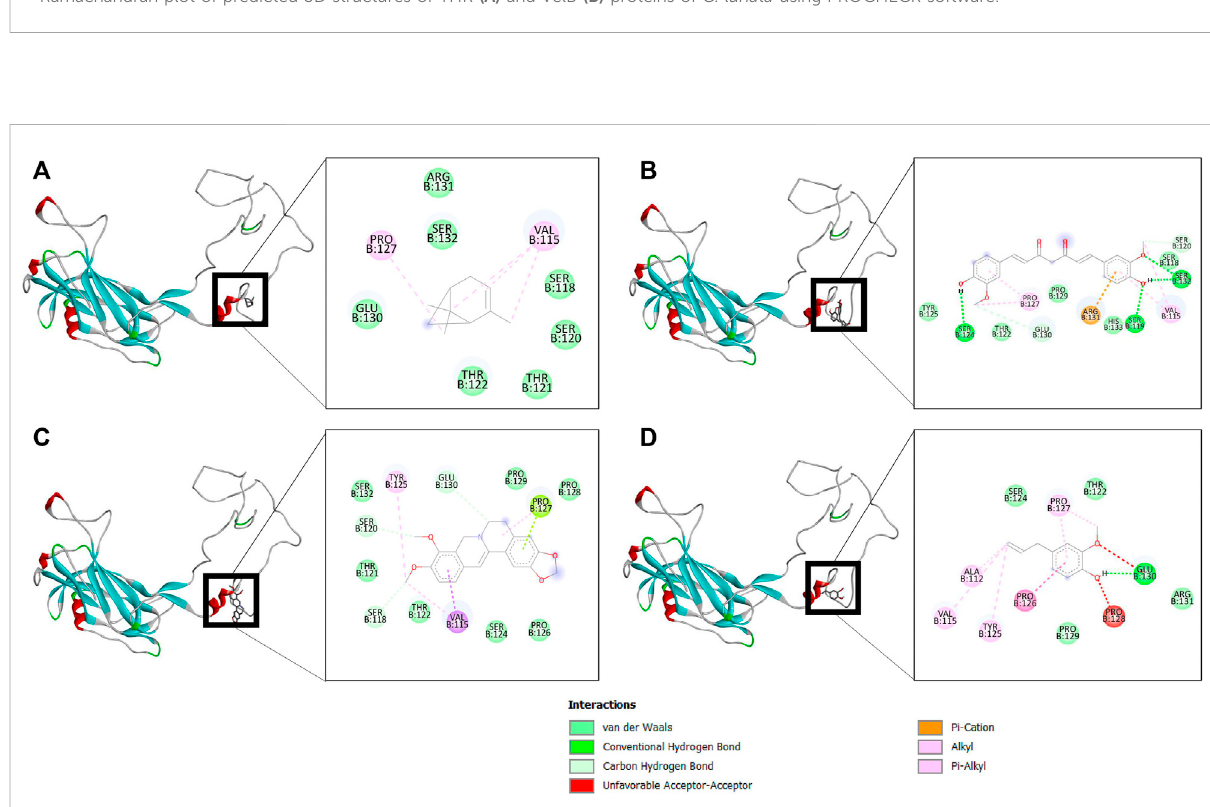
FIGURE 6 Binding of (A) α -pinene, (B) curcumin, (C) berberine, and (D) eugenol with VelB. Ribbon and 2D representation of VelB protein showing various interactions and docking fi t of